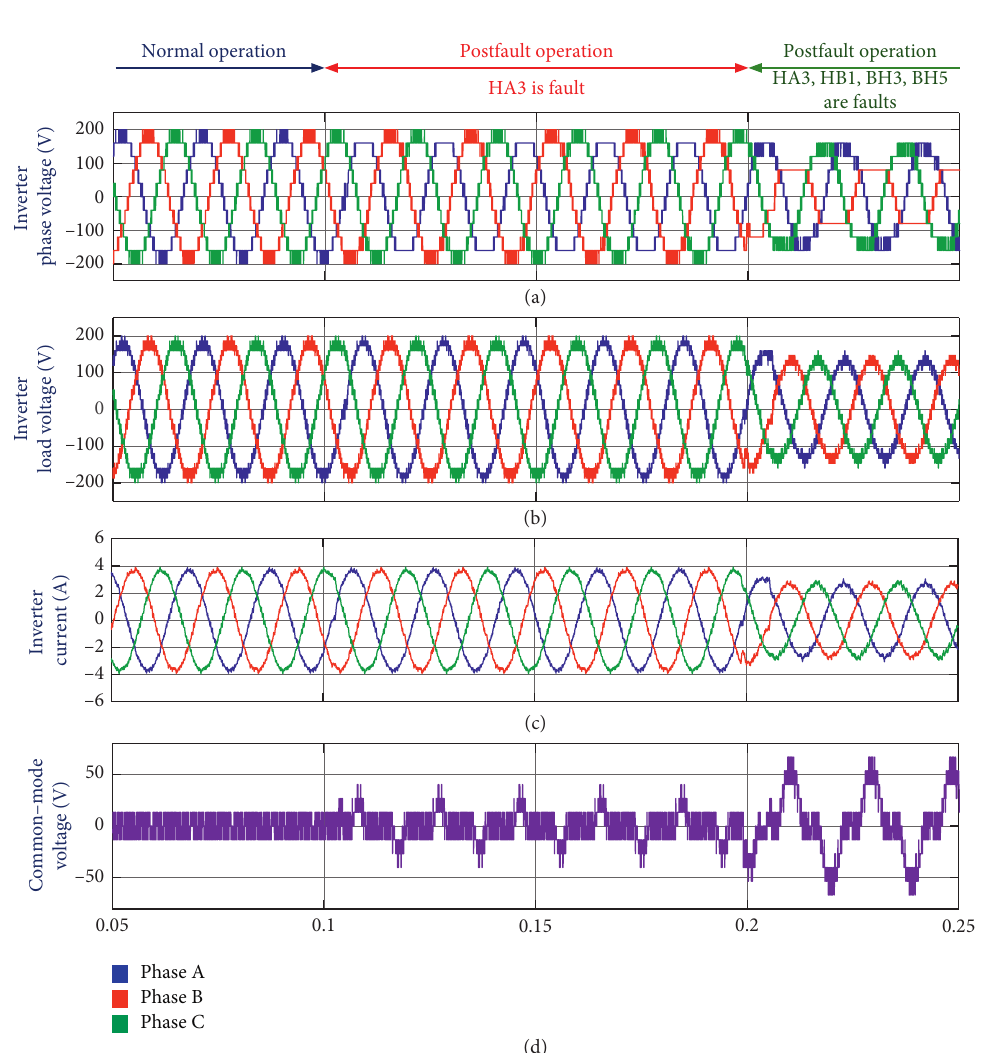
Figure 12: Waveforms of (a) inverter phase voltage, (b) inverter load voltage, (c) inverter current, and (d) CMV from